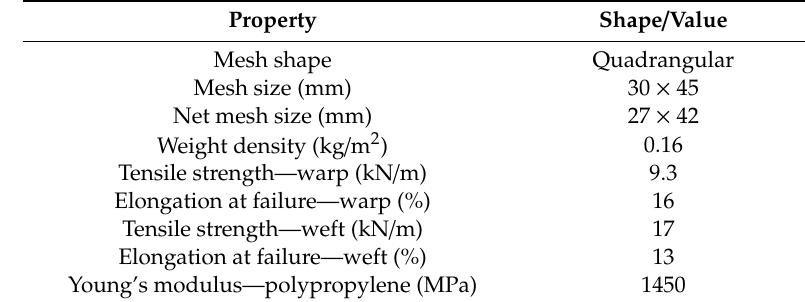
Table 3. Test matrix.